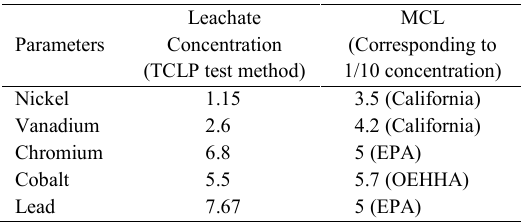
Table 2: Determination the toxicity and hazardousness of heavy metals (Values are expressed as mg/kg)